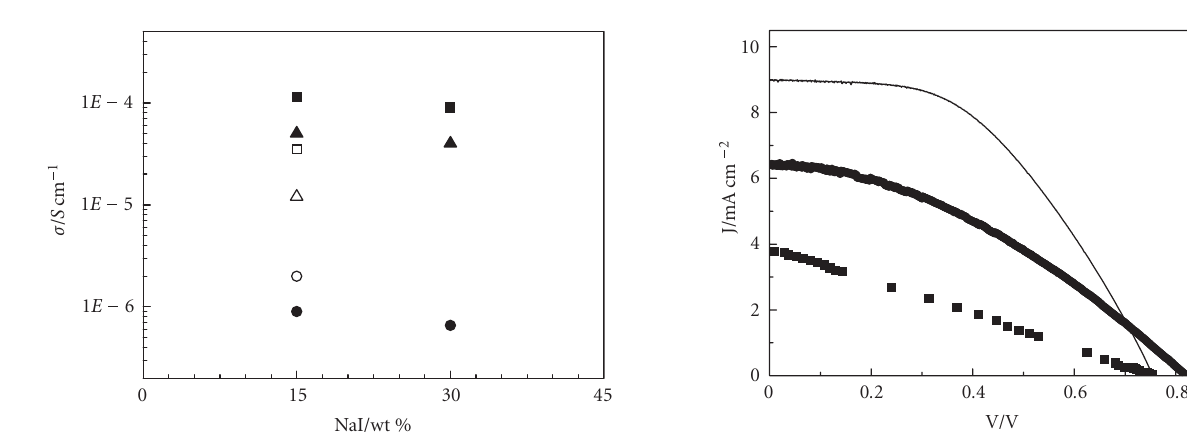
Figure 3: Ionic conductivity as a function of NaI concentration for di ff erent polymer electrolytes with (solid) and without (open) GBL: ( ◦ , • ) P(EO-EPI)50 : 50, ( Δ , (cid:2) ) P(EO-EPI)84 : 16, and ( (cid:4) , (cid:3) ) P(EO-EPI)87 : 13.